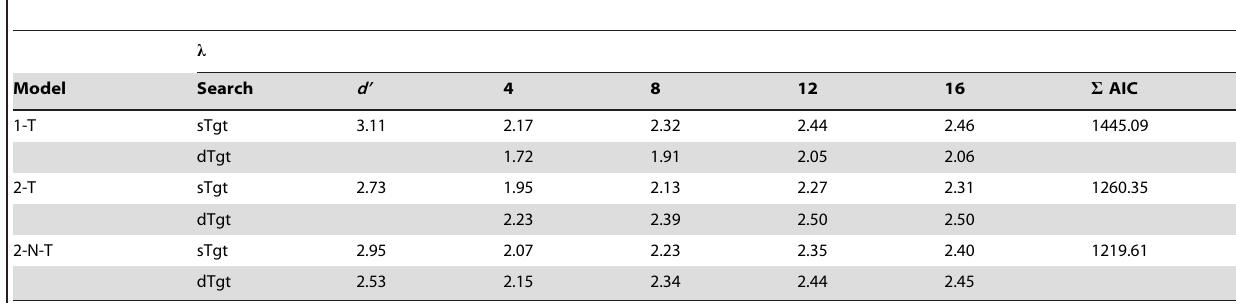
Table 3. Model comparison: mean estimated d’, response criterion ( l ) and summed AIC values for the one-template (1-T),